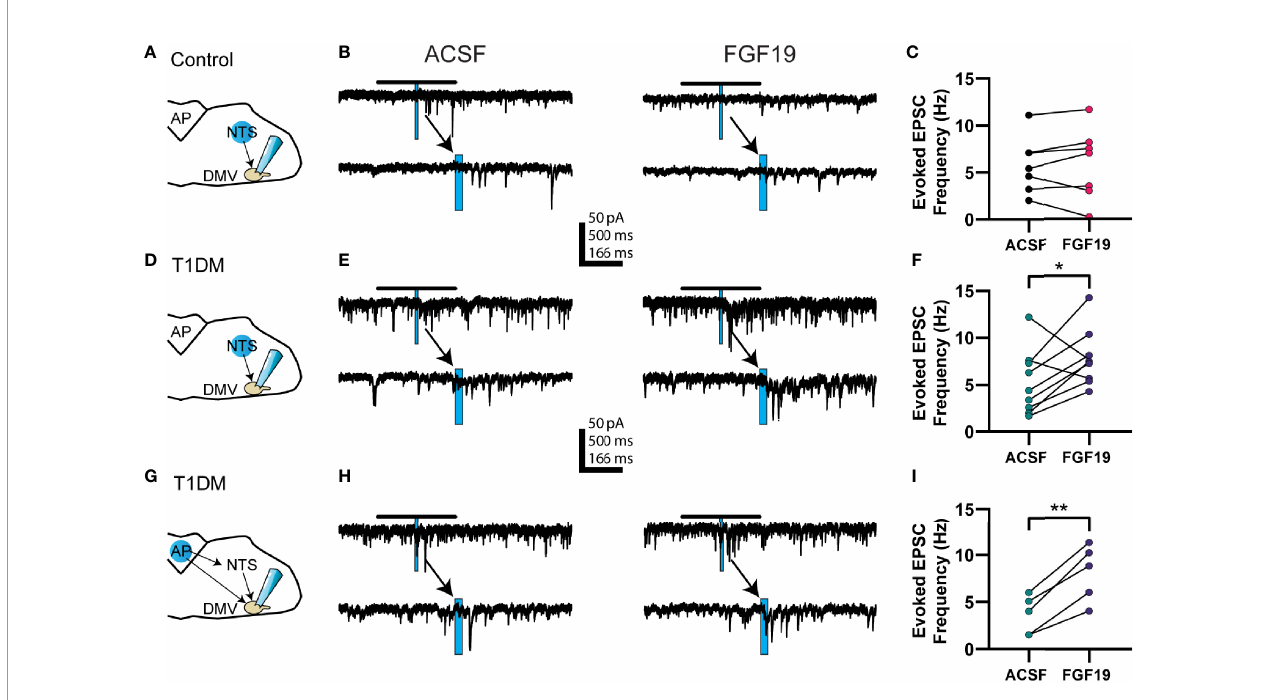
FIGURE 1 | FGF19 increases the excitability of glutamatergic AP and NTS neurons that project to the DMV in hyperglycemic mice. (A) Diagram showing a typical stimulation and recording location for cells in (B, C) (normoglycemic control mice). (B) Representative voltage clamp recordings of evoked EPSCs for the NTS to DMV circuit in control mice. (C) Evoked EPSC response in control mice before and after addition of FGF19 (230 pM; n = 7; *p > 0.05). (D) Diagram showing a typical stimulation and recording location for cells in (E, F) (hyperglycemic mice). (E) Representative voltage clamp recordings of evoked EPSCs for the NTS to DMV circuit in hyperglycemic, type 1 diabetic mice (T1DM). (F) Evoked EPSC response in this group before and after addition of FGF19 (n = 10; *p < 0.05). (G) Diagram showing a typical stimulation and recording location for cells in (H, I) (hyperglycemic mice). (H) Representative voltage clamp recordings of evoked EPSCs for the AP to DMV circuit in T1DM mice. (I) Evoked EPSC response in this group before and after addition of FGF19 (n = 5; **p < 0.01). In representative traces, blue rectangle indicates stimulation time and duration. Arrows point to an expanded trace showing 500 ms before and after stimulation. All cells recorded at -85 mV. In (A , D , G) , the blue circle represents a typical photostimulation region. The actual area of photostimulation was smaller in diameter (~75 µm) than the circle pictured and stimuli were applied to multiple areas in the indicated nucleus. Paired t-test used for all analyses. All recordings performed in the presence of MNI-caged glutamate (250 µM) and picrotoxin (100